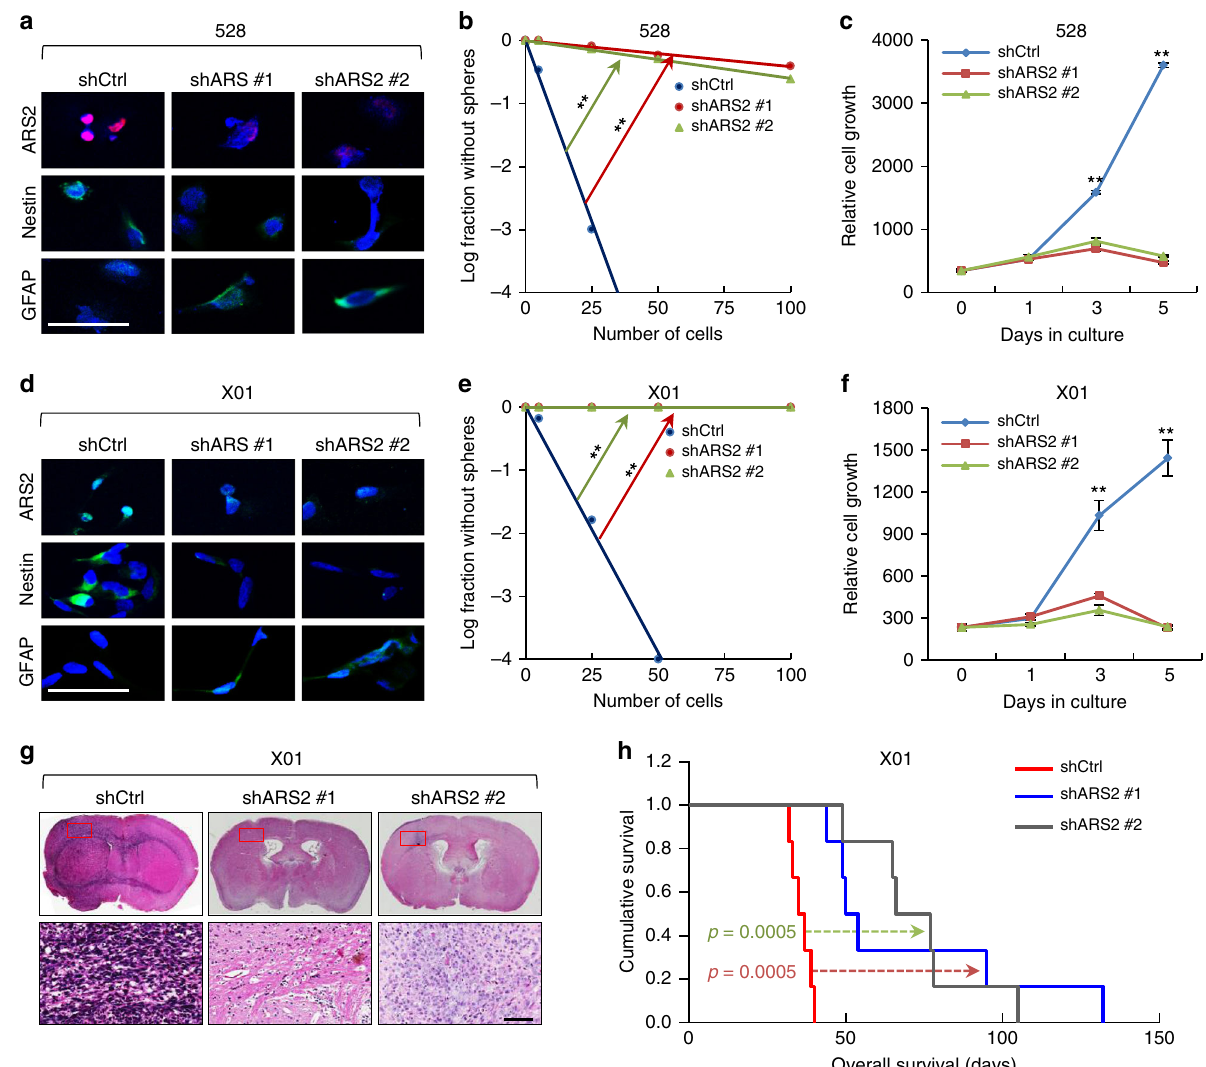
Fig. 2 ARS2 regulates the stemness and tumorigenesis of GSCs. a Representative immunocytochemistry (ICC) images of ARS2, Nestin, and GFAP in control 528 cells (528-shCtrl), and two different ARS2-knockdown 528 cell lines (528-shARS2 #1 and 528-shARS2 #2). Nuclei were counterstained with DAPI (blue). Scale bar, 50 μ m. b Limiting dilution assays (LDAs) performed using 528-shCtrl, 528-shARS2 #1, and 528-shARS2 #2 cells. ( n = 24, ** P < 0.01, t -test). c Cell proliferation assays performed using 528-shCtrl, 528-shARS2 #1, and 528-shARS2 #2 cells. All error bars represent mean ± standard error of the mean (SEM; n = 3). ** P < 0.01, t -test. d Representa t ive ICC images of ARS2, Nestin, and GFAP in X01-shCtrl, X01-shARS2 #1, and X01-shARS2 #2 cells. Nuclei were counterstained with DAPI (blue). Scale bar, 50 μ m. e LDAs performed using X0-shCtrl, X01-shARS2 #1, and X01-shARS2 #2 cells. ( n = 24, ** P < 0.01, t -test). f Cell proliferation assays performed using X01-shCtrl, X01-shARS2 #1, and X01-shARS2 #2 cells. All error bars represent mean ± SEM ( n = 3). ** P < 0.01, t -test. g H&E staining of the whole brains from mice implanted with X01-shCtrl, X01-shARS2 #1, or X01-shARS2 #2 cells. Scale bar, 100 μ m. The sample is extracted at 42 days after cell injection. h Kaplan – Meier survival plots for the orthotopic xenograft mouse model ( n = 6; 1 × 10 5 cells injected per mouse, log-rank test). Median survival of the orthotopic mice injected with X01-shCtrl, X01-shARS2 #1, or X01-shARS2 #2 was 36 days, 52 days, and 71.5 days, covering the − 1300 to + 26 bp region relative to the transcription system to monitor the expression of a luciferase reporter gene start site (TSS) of MGLL (Supplementary Fig. 3a). As shown in linked to the upstream promoter region, identi fi ed above, supplementary Fig. 3b, antibodies against ARS2 effectively containing binding site(s) for ARS2 (Fig. 3h). These reporter immunoprecipitated a speci fi c region upstream of the MGLL assays were performed in GSC X01 cells, with or without co- gene corresponding to regions 3 ( − 1018 to − 887 bp) and 4 infection with an ARS2-speci fi c shRNA-expressing lentivirus. As ( − 1300 to − 1093 bp). The relative enrichment of ARS2 in shown in Fig. 3h, ARS2 knockdown in X01 cells signi fi cantly regions 3 and 4 was assessed by quantitative polymerase chain decreased relative luciferase expression, indicating reduced reaction (qPCR), which revealed 5- and 25-fold higher levels of transcriptional activity of ARS2 toward MGLL . Collectively, these ARS2 occupancy in regions ampli fi ed by primer sets 3 and 4, data demonstrate that a number of genes are potentially regulated respectively, compared with immunoprecipitations with control at the transcriptional level by ARS2, and speci fi cally identify IgG (Fig. 3f, g). To con fi rm the transcriptional relationship MGLL as a novel target of ARS2 in GSCs, consistent with the role between ARS2 and MGLL , we used a lentiviral-based reporter of MAGL in aggressive cancers.